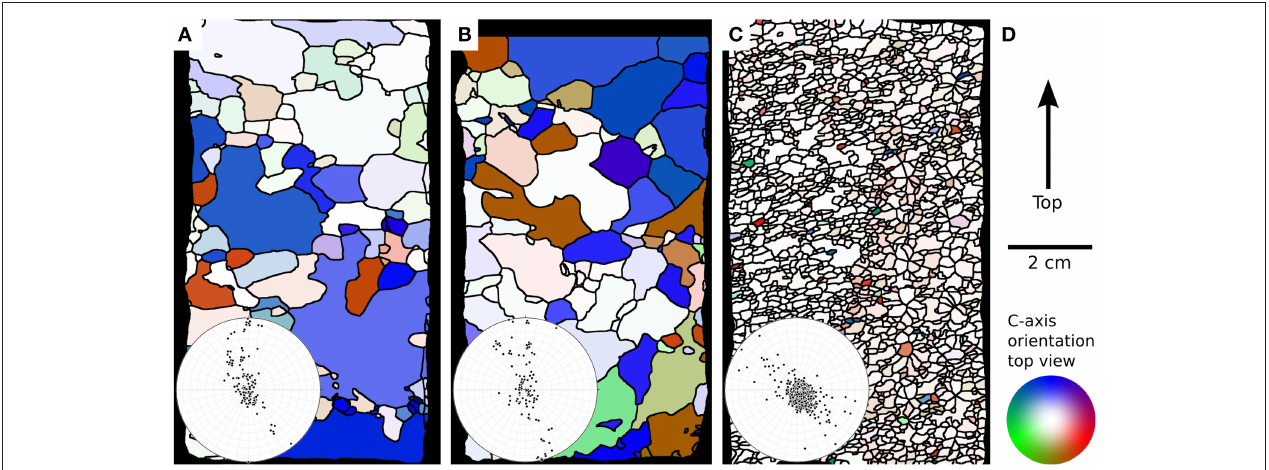
FIGURE 1 | Different grain sizes and c-axis orientations in the three sections selected for Raman analysis. (A) section 2371-4. (B) section 2371-9. (C) section 2392-2. The pole figures represent stereographic projections of the average c-axis orientations (one point per grain) onto the horizontal plane. (D) legend indicating the orientation of the main ice core axis, scale bar and color code for the orientation of c-axes projected onto the horizontal plane. White color indicates c-axis aligned along the ice-core axis (vertical